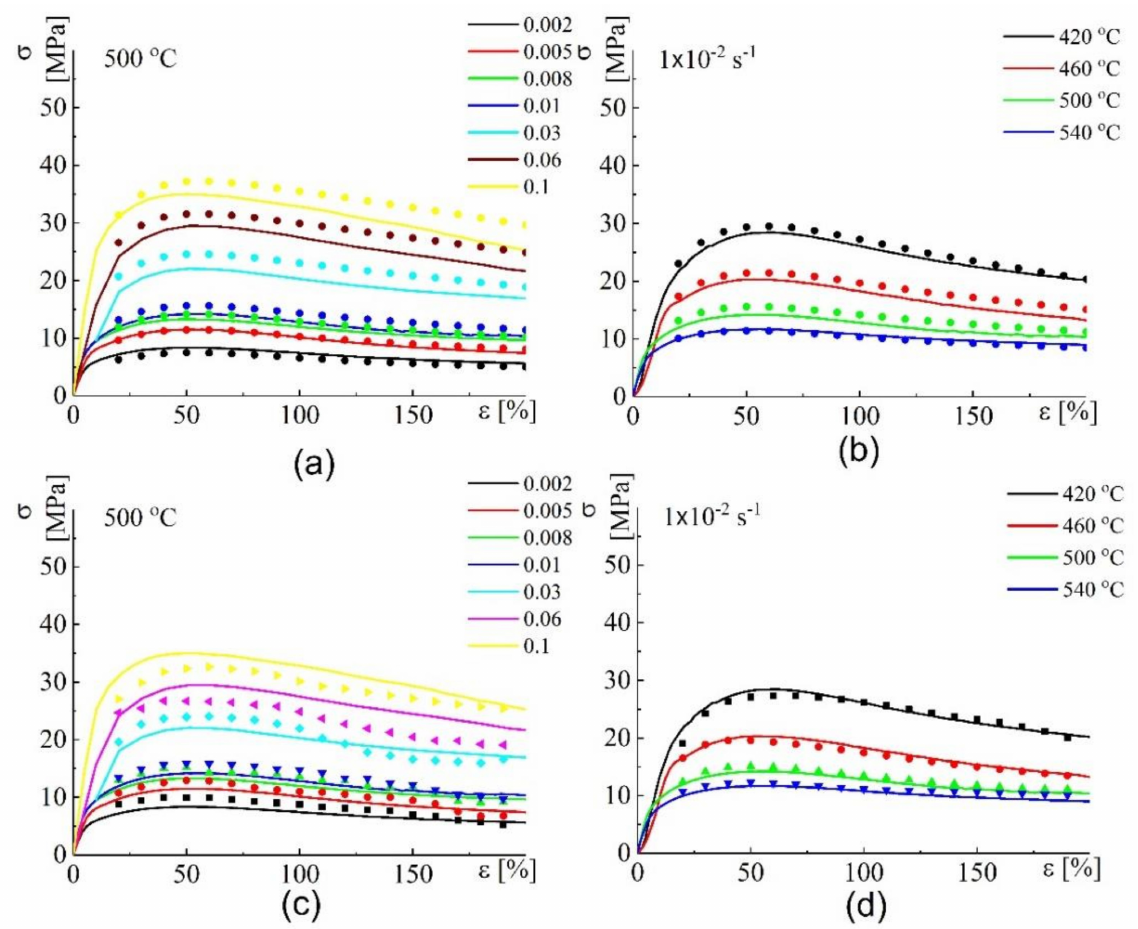
Figure 12. Compression between the experimental and predicted data by ( a , b ) ACE and ( c , d ) ANN at ( a , c ) 500 ◦ C and ( b , d ) 1 × 10 − 2 s − 1.